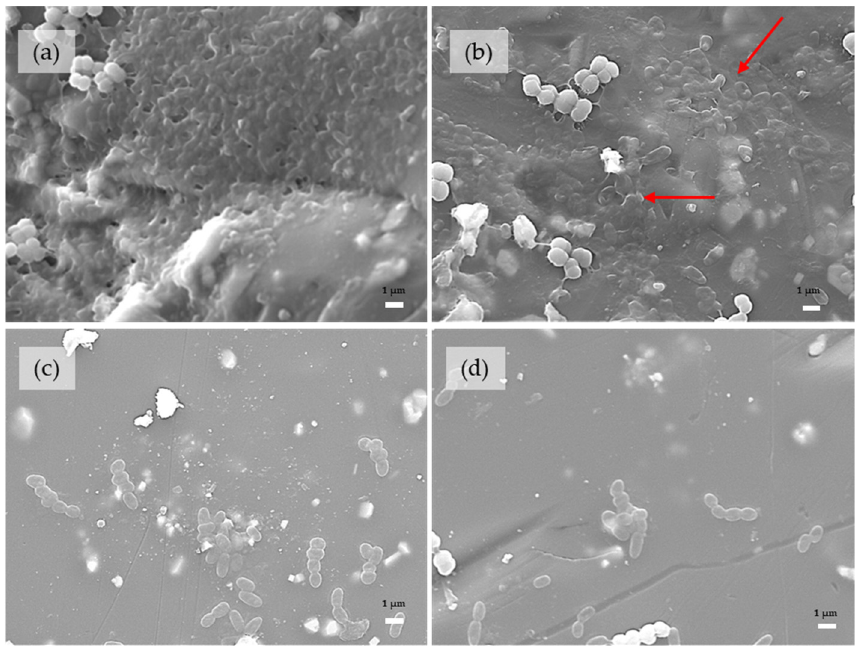
Figure 5. Representative scanning electron microscopy (SEM) micrographs of biofilm inhibition after treatment with UV 20 s ( b ), 0.4 mg/L of Cl for 1 min ( c ), combination of UV for 20 s and Cl for 1 min ( d ); ( a ) represented untreated control of 5-day-old biofilm. Magnifications 5000×. Red arrows point out bacteria embedded in EPS.